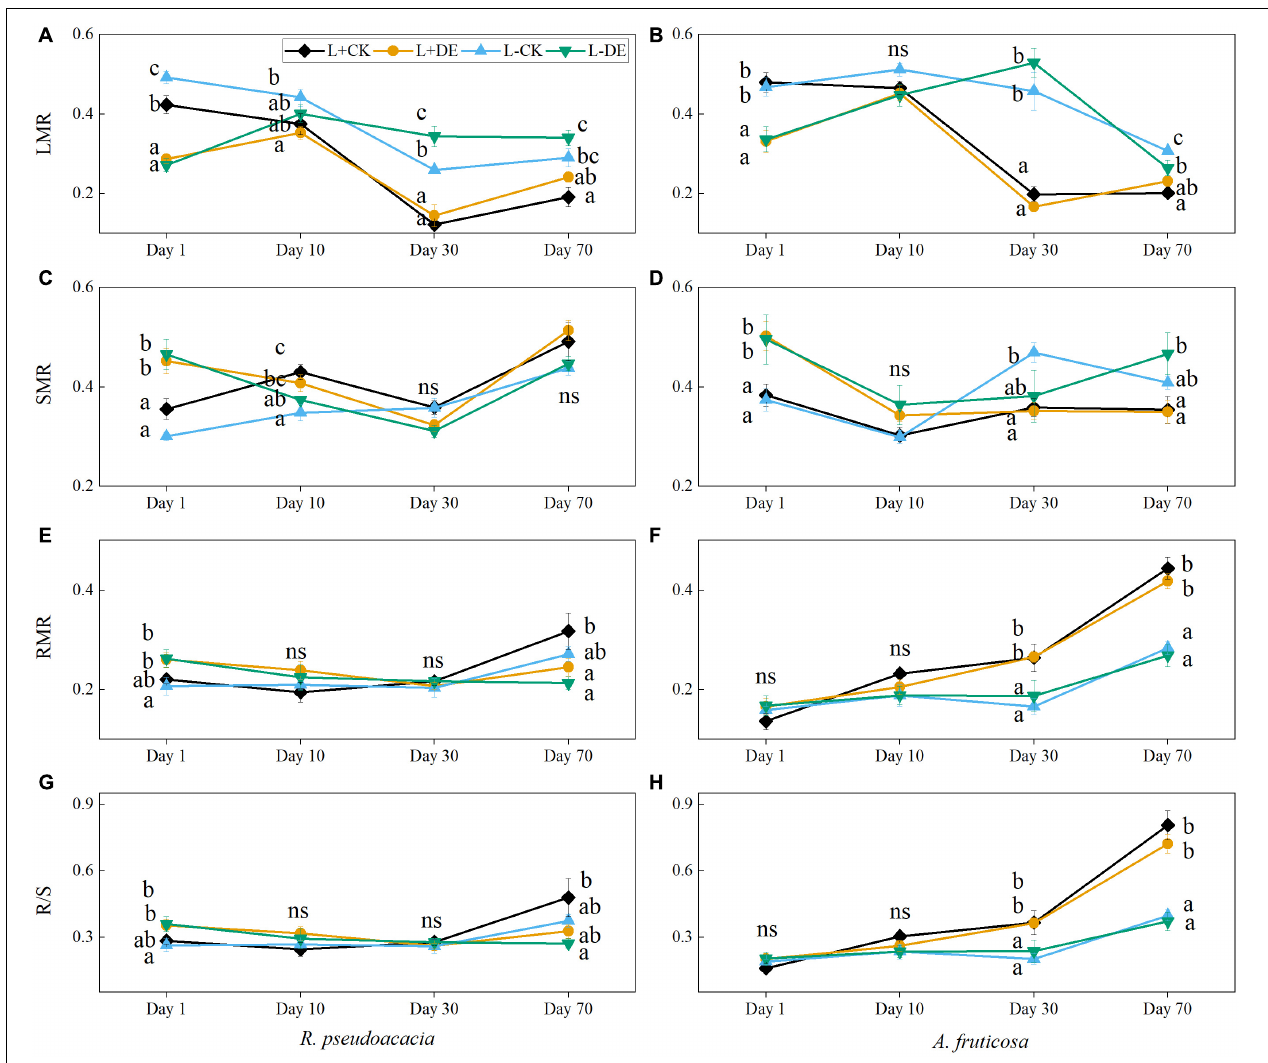
FIGURE 2 | Seedling biomass partitioning parameters of R. pseudoacacia (A,C,E,G) and A. fruticosa (B,D,F,H) under different light and defoliation treatments. The values are shown as mean ± SE ( n = 4). Different letters indicate significant differences among different treatments in each sampling according to Duncan’s test ( p < 0.05). L + CK, high light condition with no defoliation; L + DE, high light condition treatment with defoliation; L − CK, low light condition with no defoliation; L − DE, low light condition with